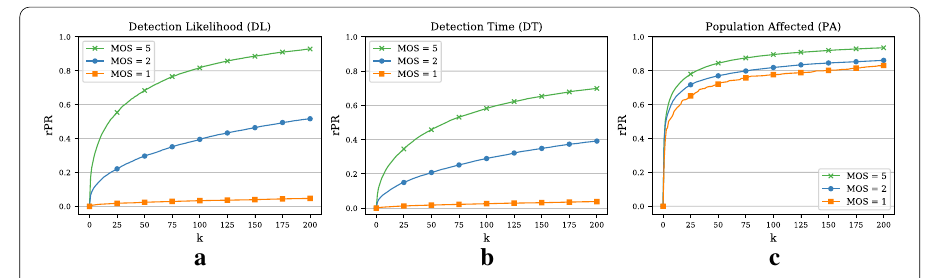
Fig. 6 Effect of minimal outbreak size (Example 1). a Relative penalty reduction for the DL objective and different minimal outbreak sizes (MOS). b Relative penalty reduction for the DT objective and different MOS. c Relative penalty reduction for the PA objective and different